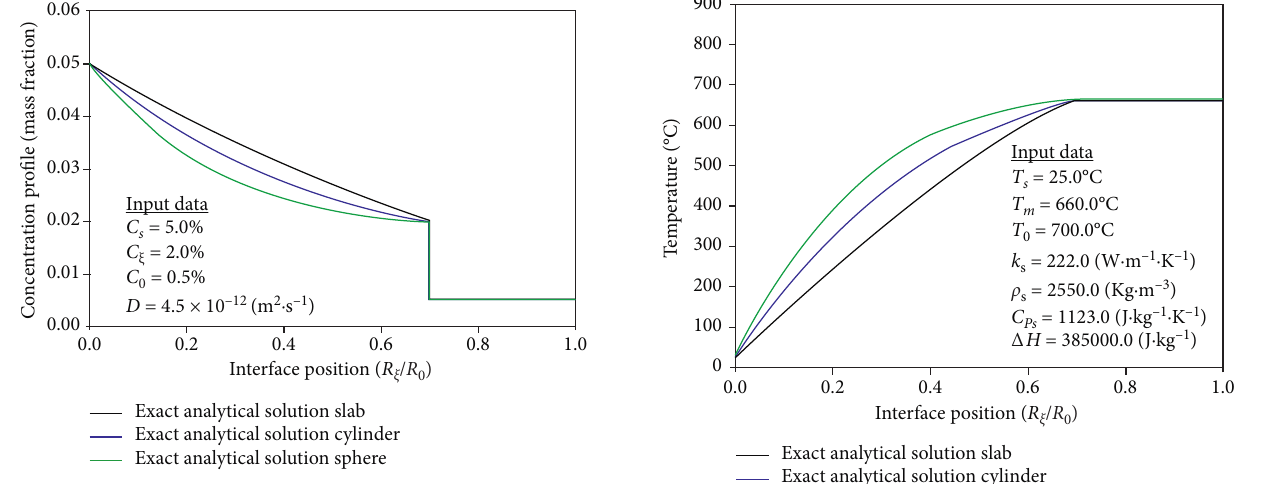
) at 70% of R / R . ξ 0 0